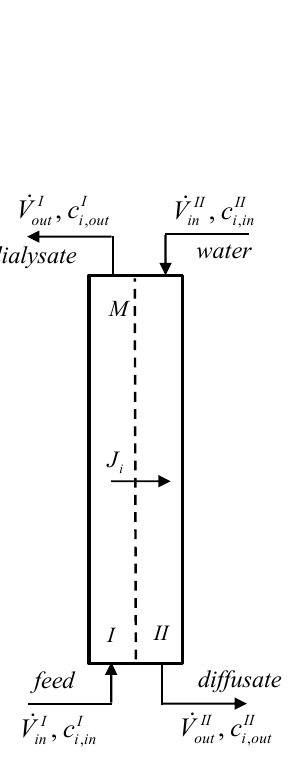
Figure 1. Scheme of the continuous dialyzer: M —membrane; I and II —compartments I and II . Equation (1) was used to calculate the acid recovery yield (HF + HNO 3 ), and Equation (2) From the balance of i ions over the differential volume of compartments I and II writ ‐ to determine the rejection coefficient for metal ions (Fe 3+ , Cr 3+ and Ni 2+